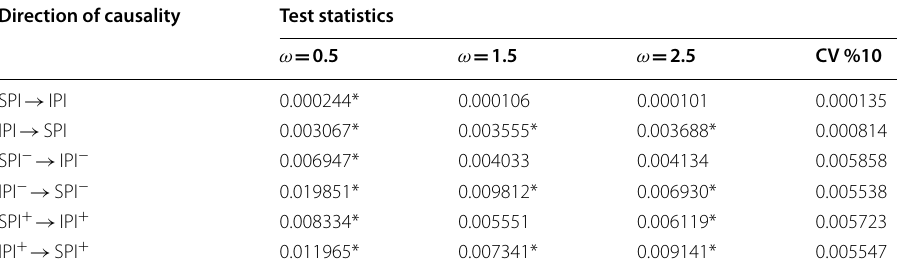
*The existence of causality runs from the first variable to the second one